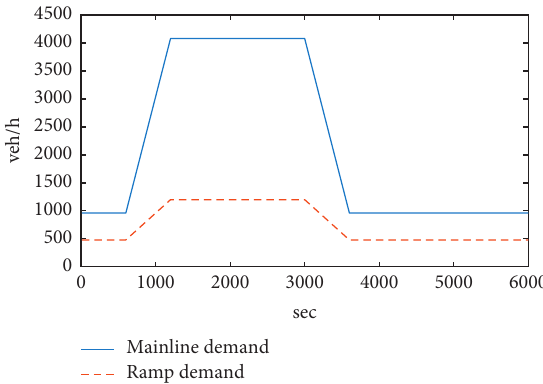
Figure 4: Traffic demands for the mainline and the